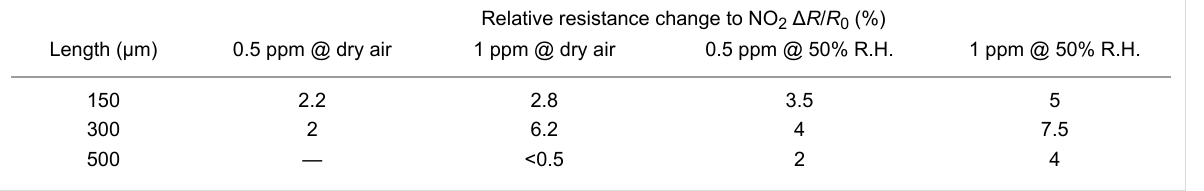
Table 1: Relative resistance change to NO 2 depending on the humidity